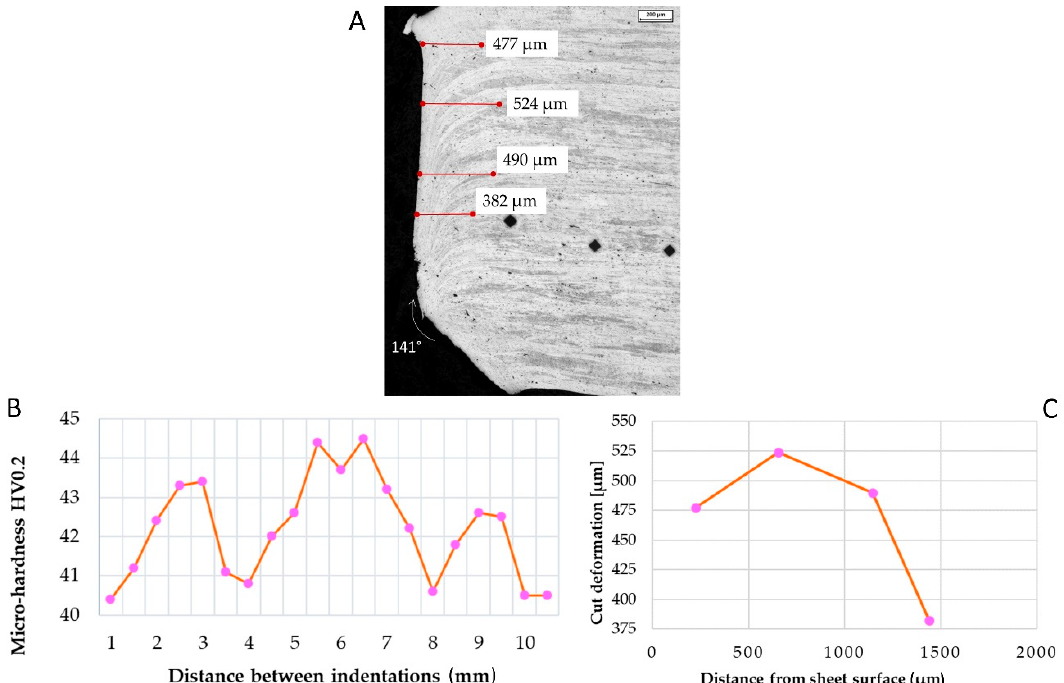
Figure 6. ( A ) Microscope image of the water jet cutting trace on AA1070 sheet. ( B ) Distortions in the first 1500 µm were documented. ( C ) Micro-hardness measured along the first 10 mm starting from the cut edge. Marker: 200 µm.